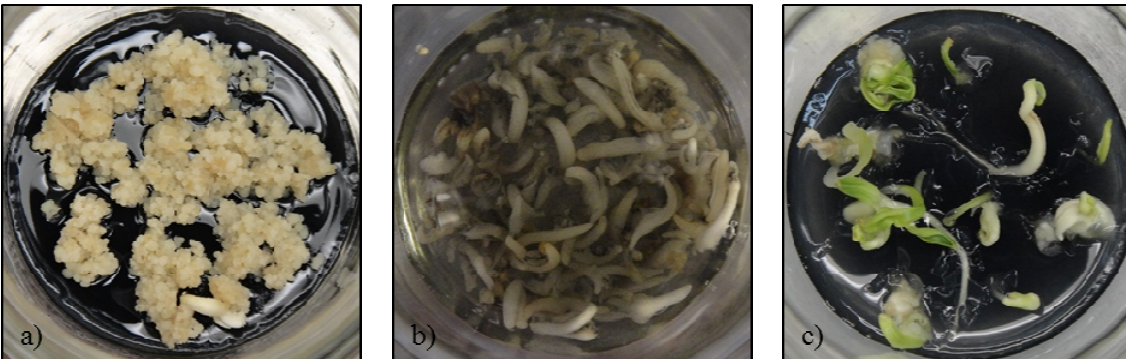
Fig. 1. Maturation and germination of date palm cv. Najda somatic embryos. a Embryogenic cultures used in the present study. b Somatic embryo maturation after 3 weeks of culture on MS medium supplemented with 30 g L -1 PEG and 40 μmol ABA followed by 9 weeks of culture on the same medium but without ABA. c Somatic embryo germination after 6 weeks of culture on MS medium supplemented with 0.5 mg L -1 NAA